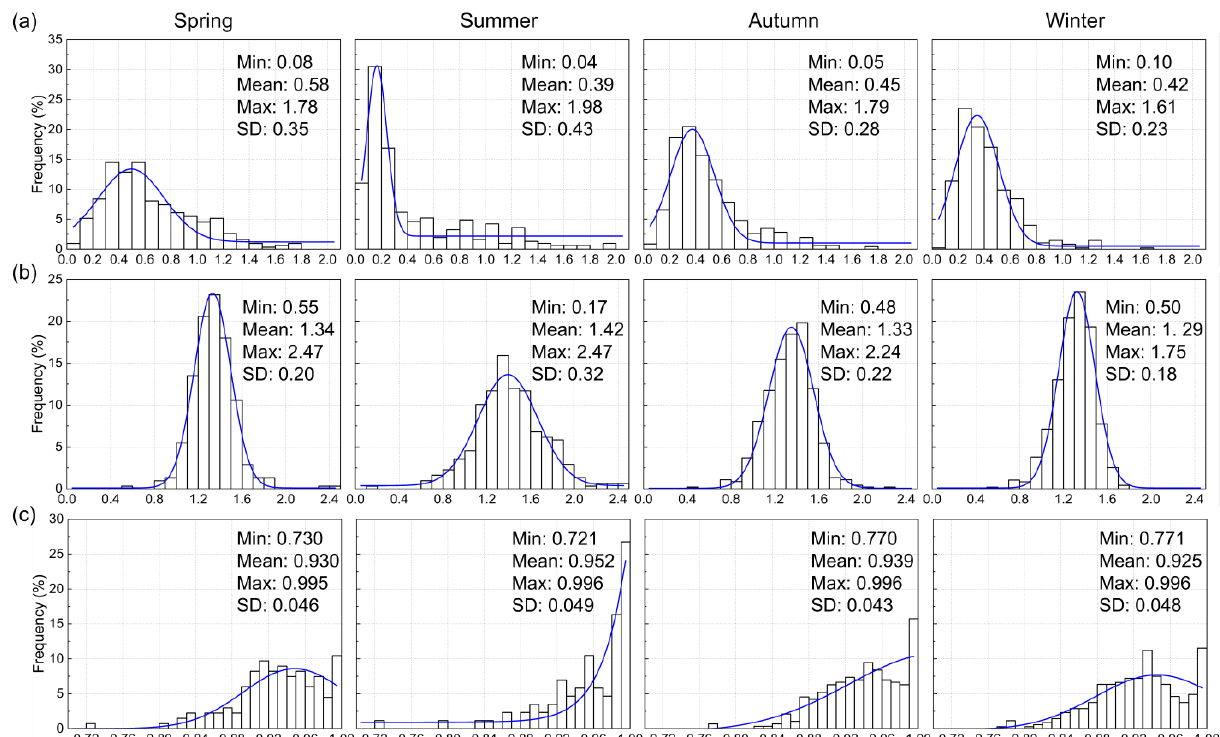
Figure 3. Multi-seasonal frequency histograms of ( a ) AOD, ( b ) AE and ( c ) SSA. The blue line is the fitting curve of the frequency histogram.